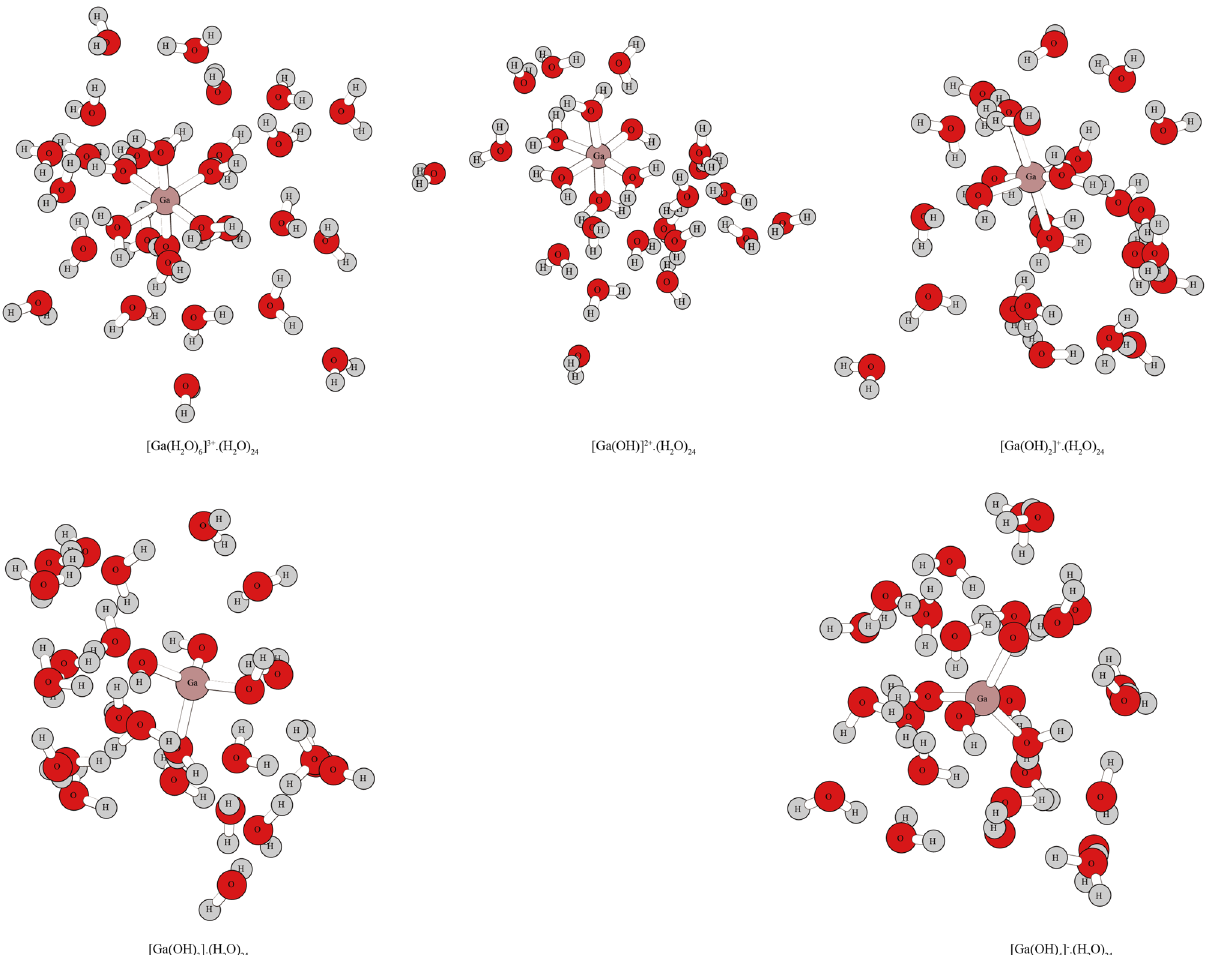
Figure 2. The cluster structures of Ga-bearing solutions. The spatial structures for [Ga(H 2 O) 6 ] 3+ ·(H 2 O) 24 , [Ga(OH)] 2+ ·(H